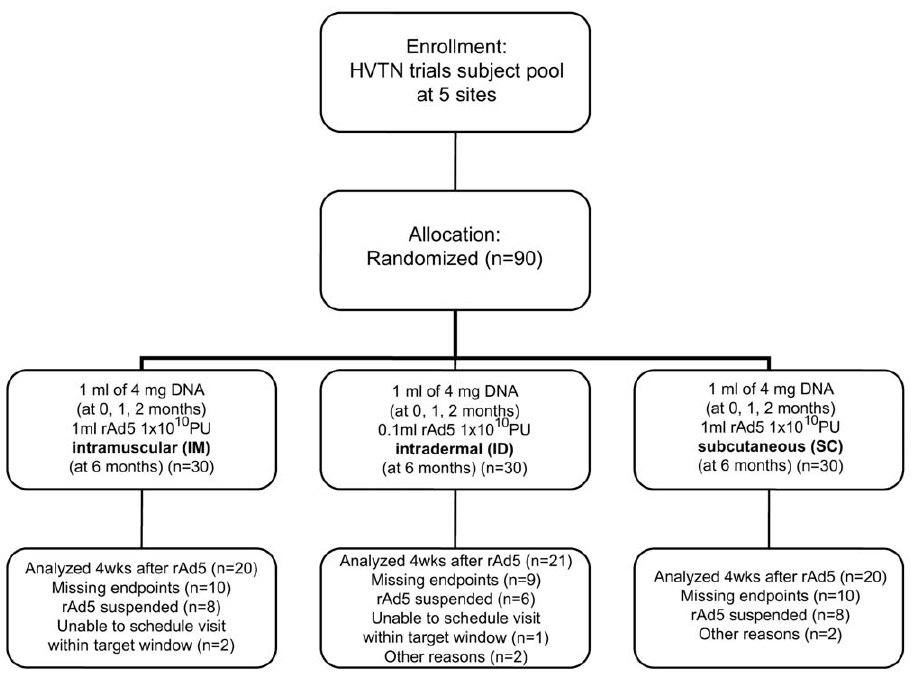
Figure 1. Study flow diagram.